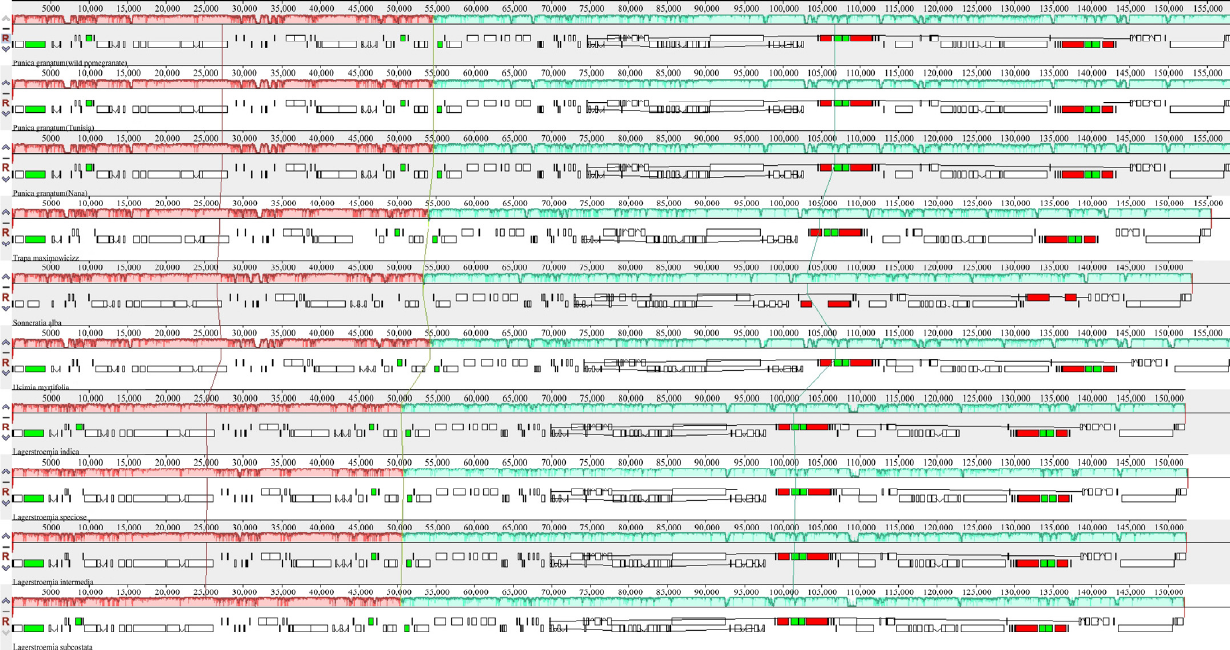
Figure 6. Illustration of the chloroplast genomes of 10 Lythraceae family cultivars rearranged by MAUVE software. The top of the alignment represents the genome of wild pomegranate, and below that represents the other species. The locally collinear blocks (LCBs) are demonstrated by the similar color and lines interconnect blocks. Here, the vertical row demonstrates the degree of conservation among positions. Moreover, short squares represent the locations of the gene in each genome, the white portion represents the CDs, the green represents tRNA, and the red color represents the rRNA.